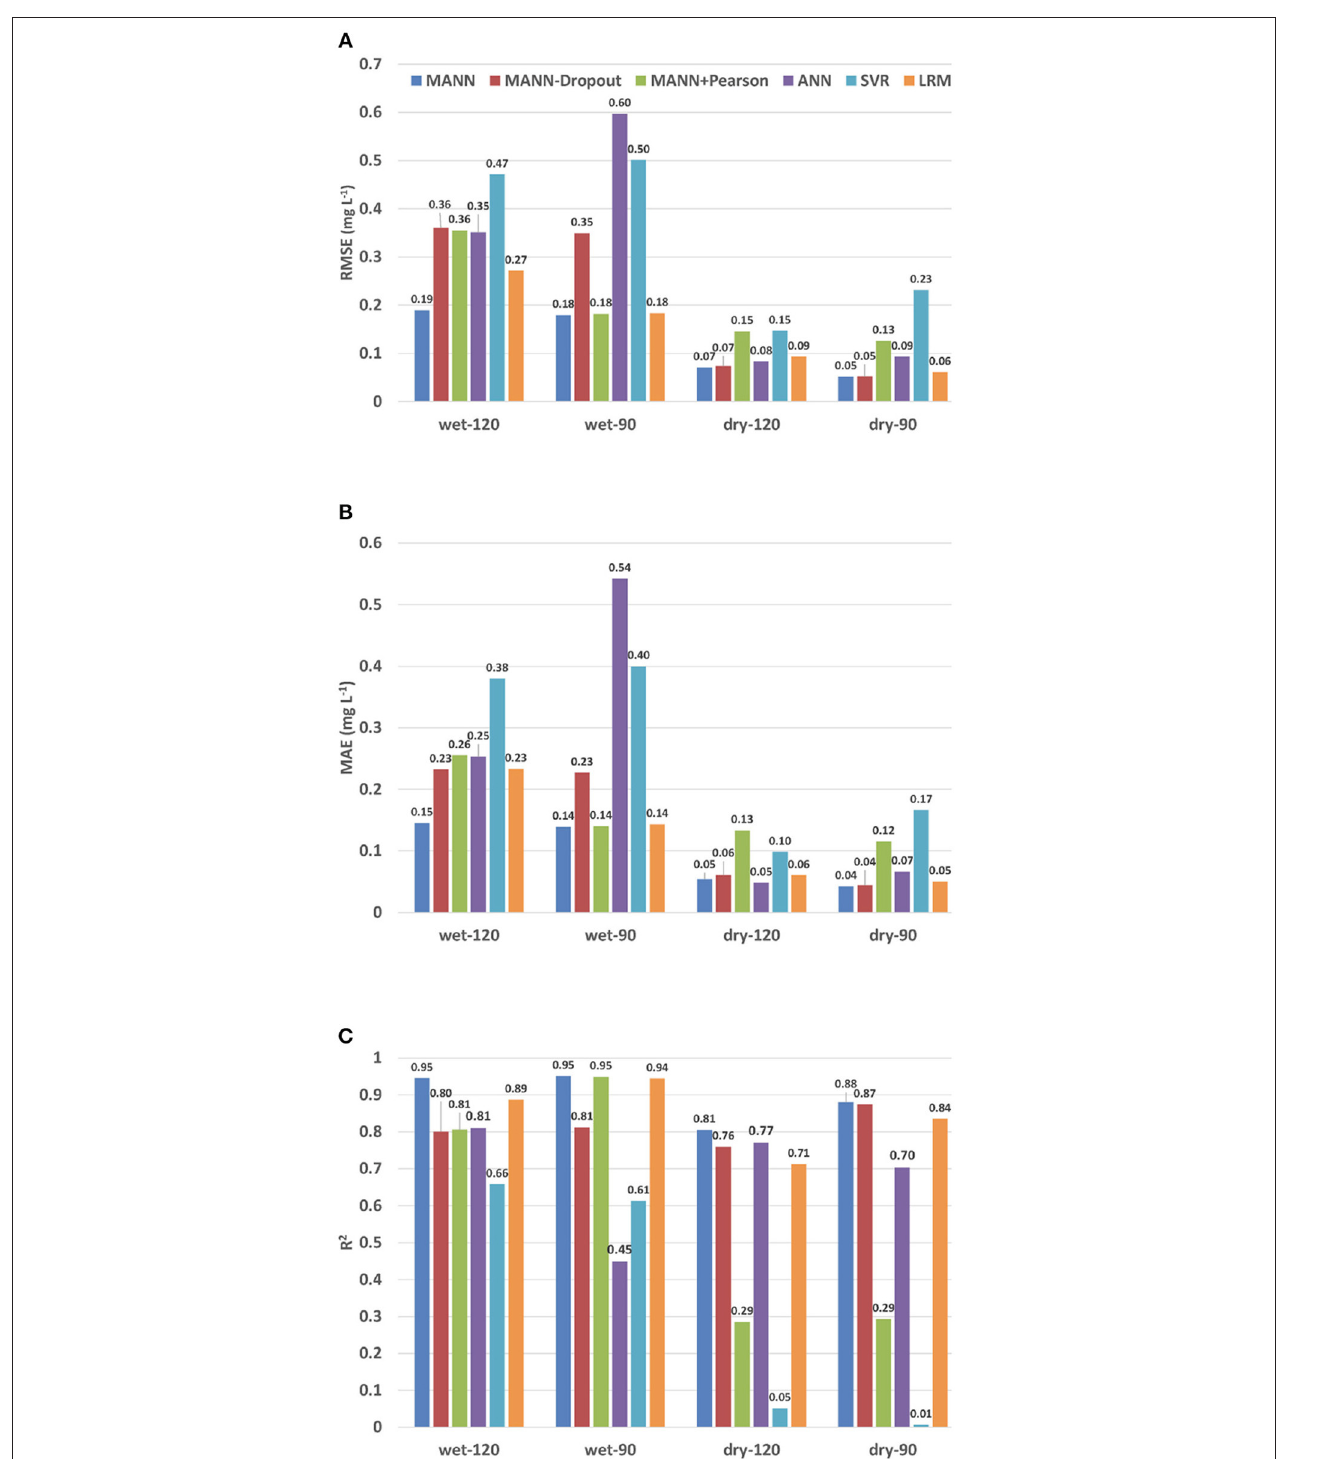
FIGURE 9 | Performance evaluation for 6 different models. Wet-90 represents the experimental case for 90 min ahead prediction for the wet season. Other cases are named in the same way. (A) RMSE of 6 different models in 4 experimental cases. (B) MAE of 6 different models in 4 experimental cases. (C) R 2 of 6 different models in 4 experimental